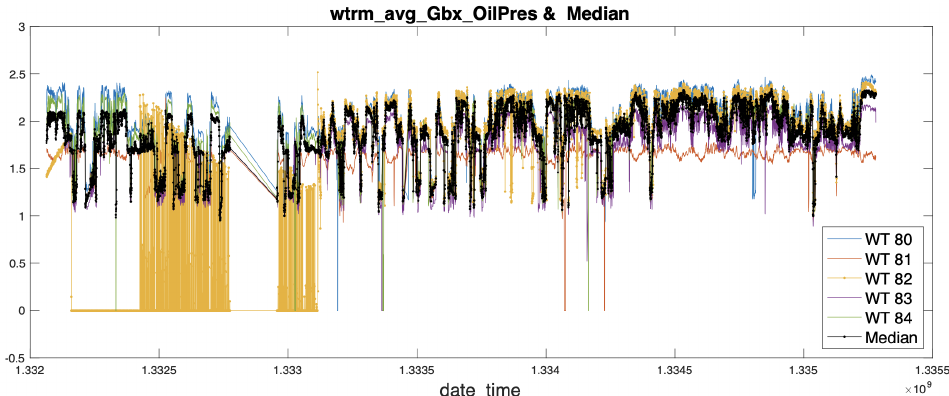
Figure 8. Reference signal (in black) of a fragment of the signals wtrm_avg_Gbx_OilPress after filtering out the